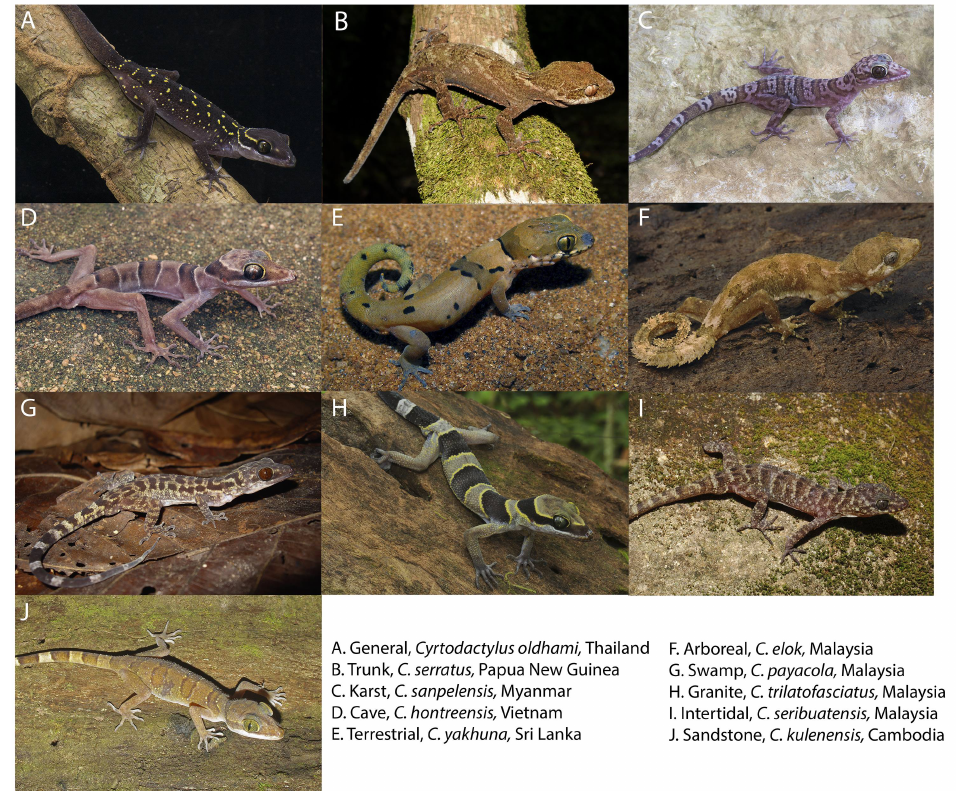
Figure 4. Representative ecotypes of the 10 different habitat preferences in the genus Cyrtodacty- lus. Photographs by ( A ) L. Lee Grismer, ( B ) Steve J. Richards, ( C , D ) L. Lee Grismer, ( E ) Suranjan Karunarathna, ( F ) L. Lee Grismer. ( G ) Evan S. H. Quah, ( H , I ) L. Lee Grismer, and ( J ) Peter